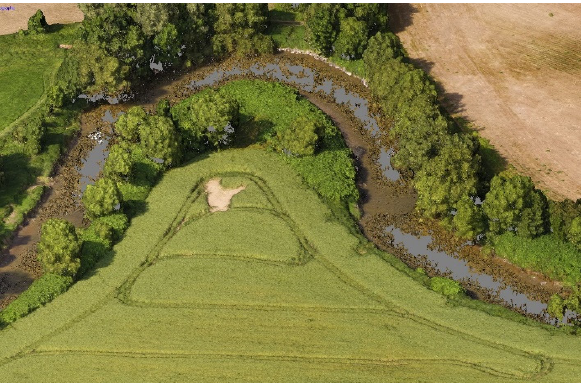
Figure 1. Example of point cloud of the area of interest.